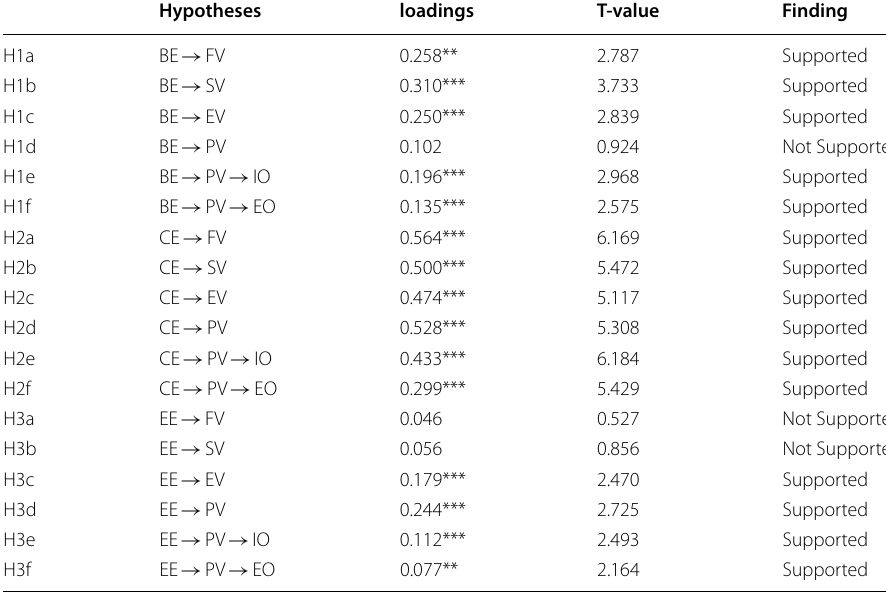
Table 6 Summary findings of hypotheses tests